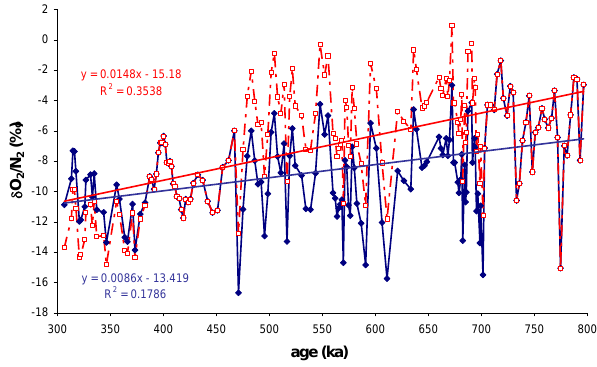
Fig. 2. Two gas loss corrections for the EDC δ O 2 /N 2 record. We propose two gas loss corrections since no accurate storage history documentation is available: “gas correction 1” (curve 1=red) shifts all Series 1 and 2 data by +6.43‰ (the average offset between Se- ries 1 and 2 when compared with Series 3), resulting in a variance of 13‰ after outlier rejection; “gas correction 2” (curve 2=blue) seeks to homogenize Series 1 and 2 with Series 3 and 4 where they